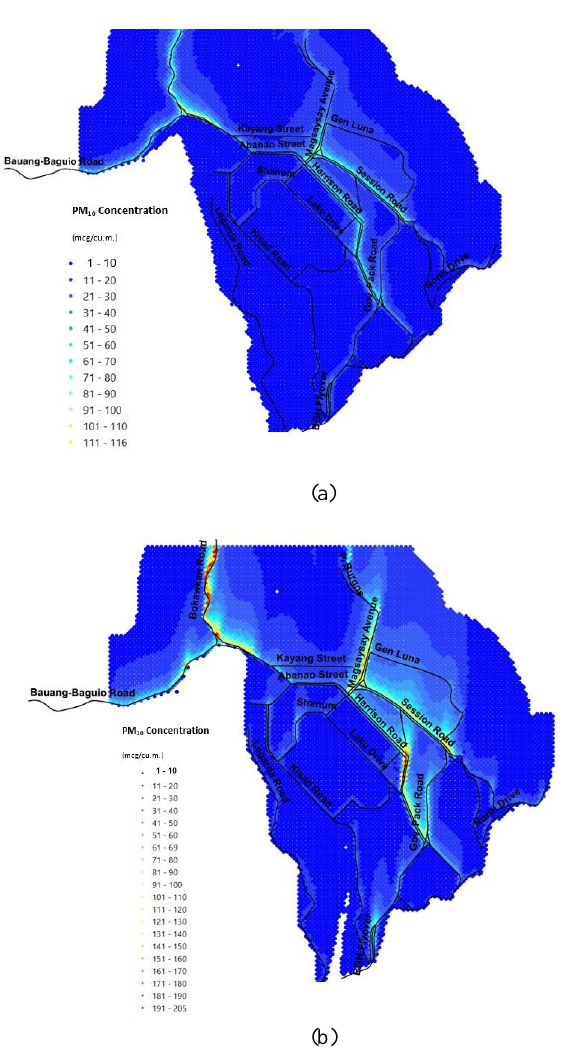
Figure 6. Dispersion modeling results for (a) daytime hour 6AM-7AM and (b) nighttime hour 6PM-7PM